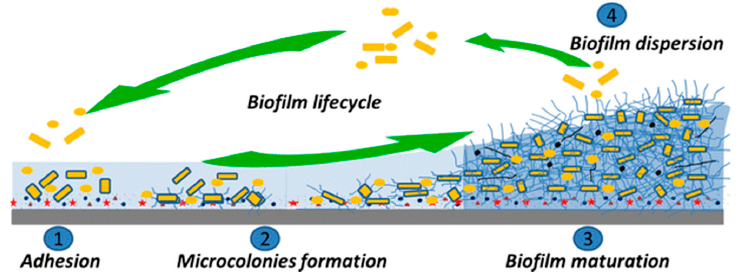
Figure 3. Schematic of biofilm formation in different stages [36].